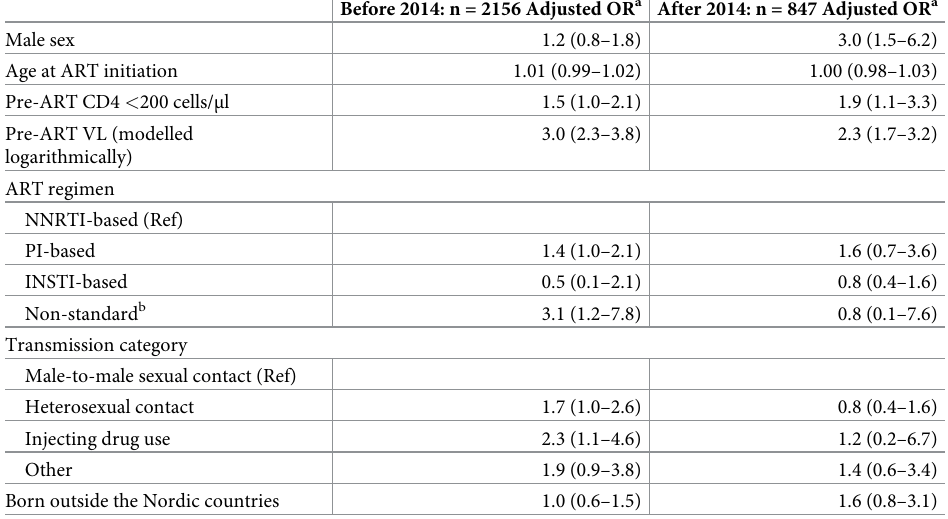
Table 4. Association between low-level viraemia and pre-ART CD4 count, pre-ART viral load and type of ART, stratified by starting ART before/after 2014. Before 2014: n = 2156 Adjusted OR a After 2014: n = 847 Adjusted OR a